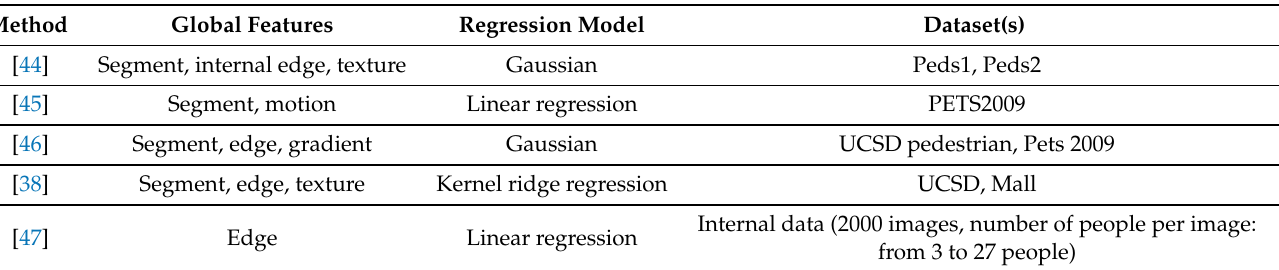
Table 1. Summary of regression-based